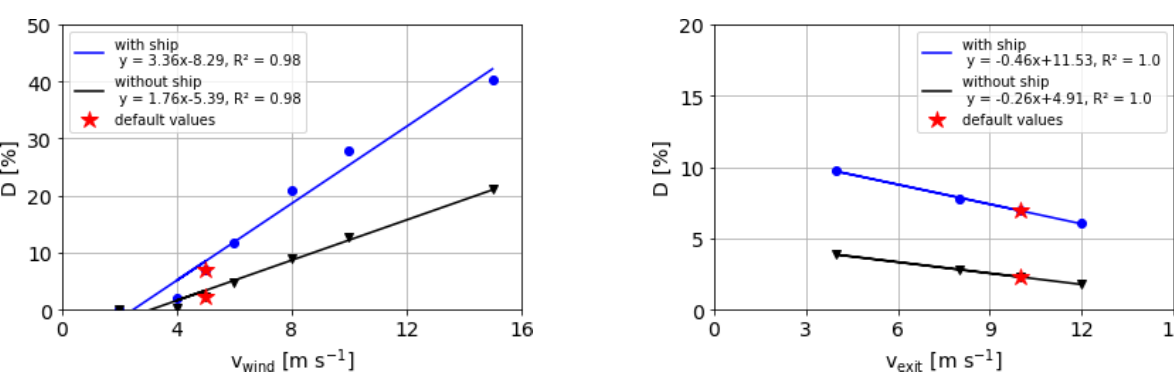
Figure 6. Dependence of the downward dispersion D on different wind speeds v wind with and without the obstacle effect.